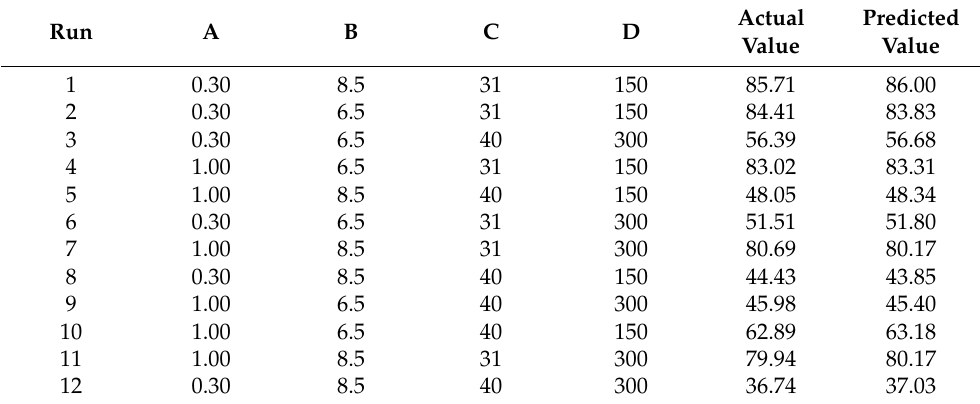
Table 8. Experimental design and results of Plackett-Burman on Reactive Red 120 decolourisation by consortium